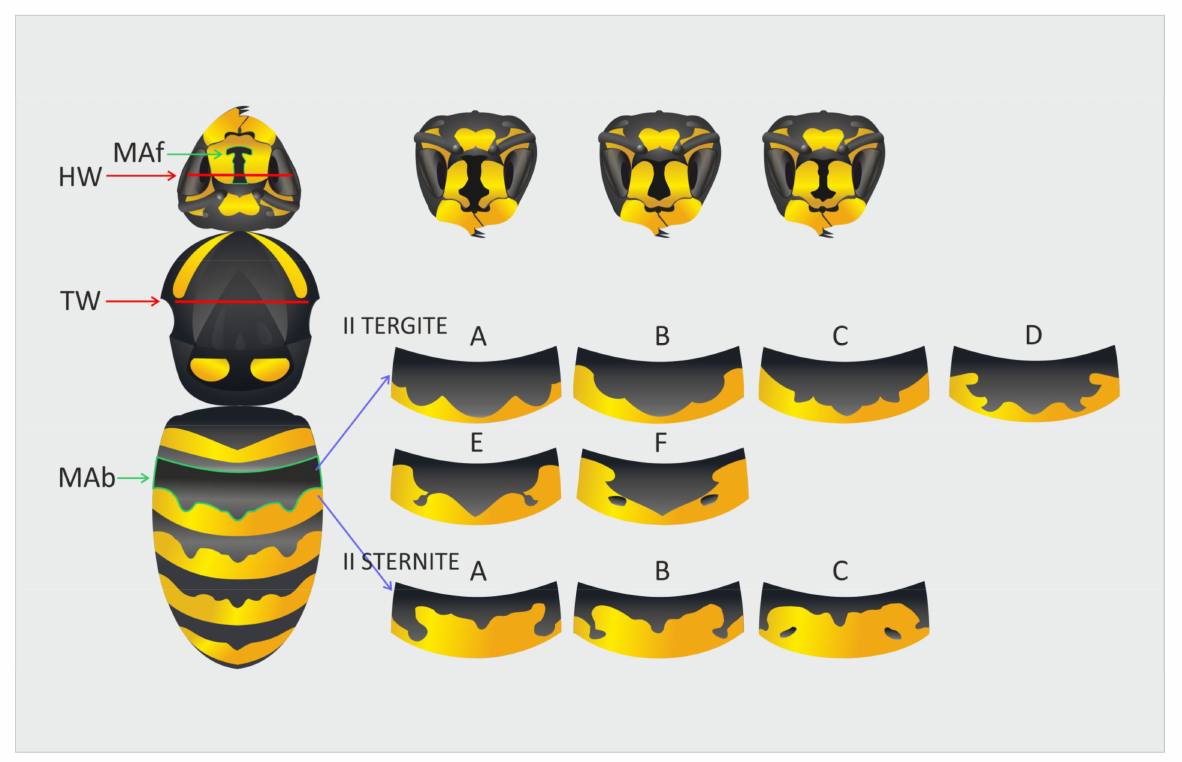
Figure 2. Morphological parameters and color traits scored from the Vespula vulgaris bodies: HW (head width), TW (thorax width), MAf (melanization area of the anchor-like melanin facial color trait), MAb (melanization area of the second tergite). Abdominal color morph variations were scored from the second tergite (A, B, C, D, E, F) and second sternite (A, B,